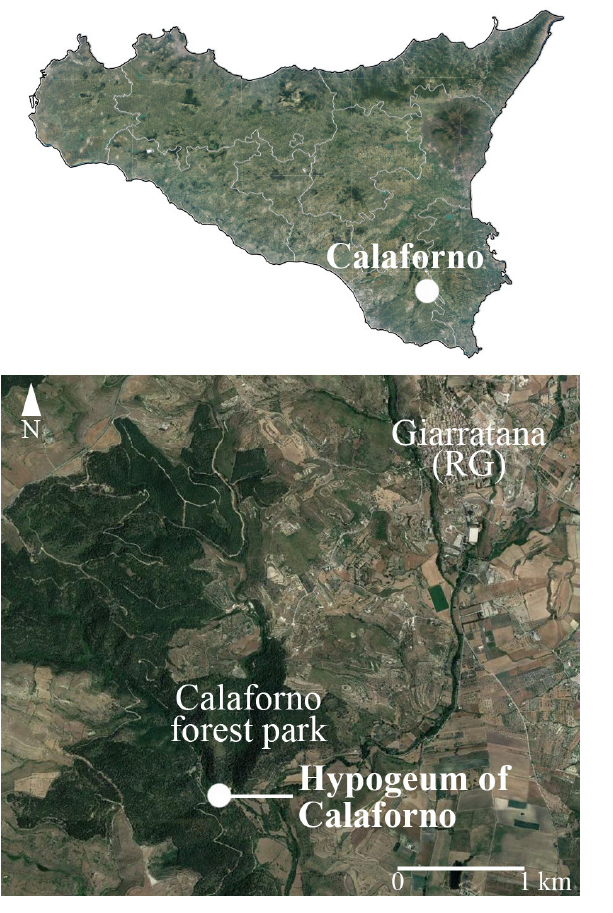
Figure 1 . The hypogeum of Calaforno